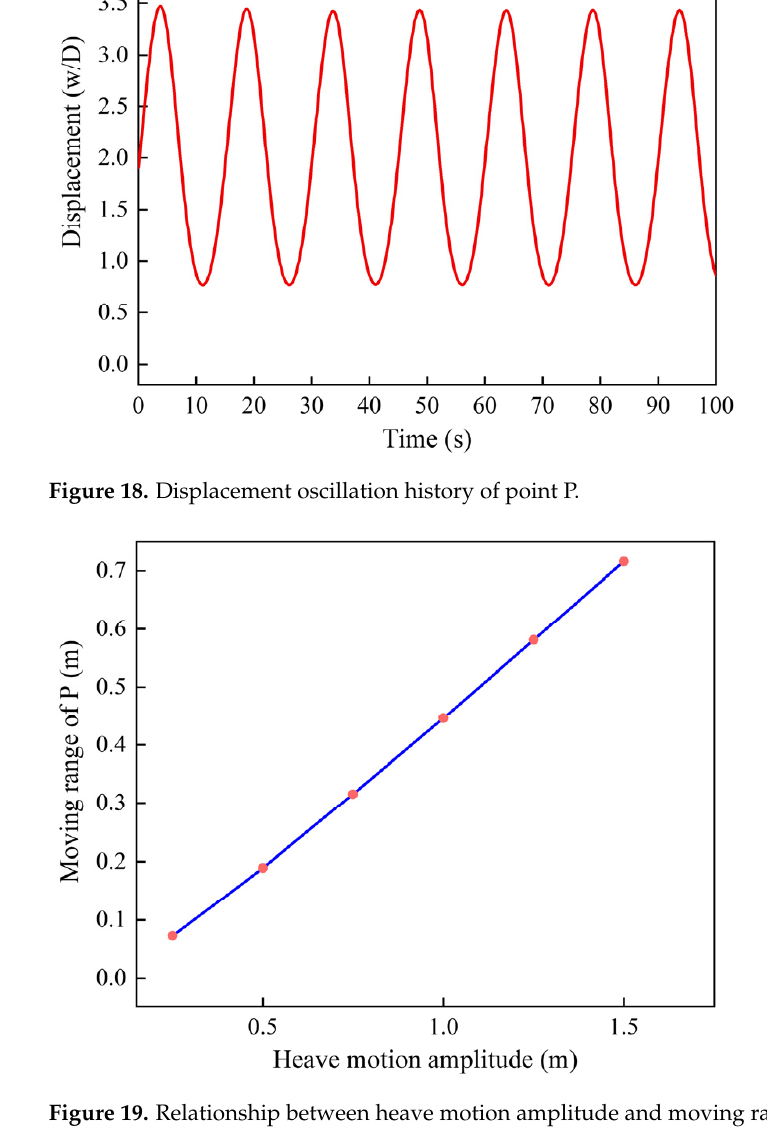
Figure 19. Relationship between heave motion amplitude and moving range of P. In the model test of the SCR, a steel pipe with a diameter of 168 mm was adopted, similar to the in situ SCR. The wall thickness was reduced to 8 mm to magnify the defor- mation under the submerged weight and bending moment, since the length of the model SCR was 17.0 m. When the riser developed its configuration, the bending moment applied to the truncated point P was within the capacity of the bending moment loading